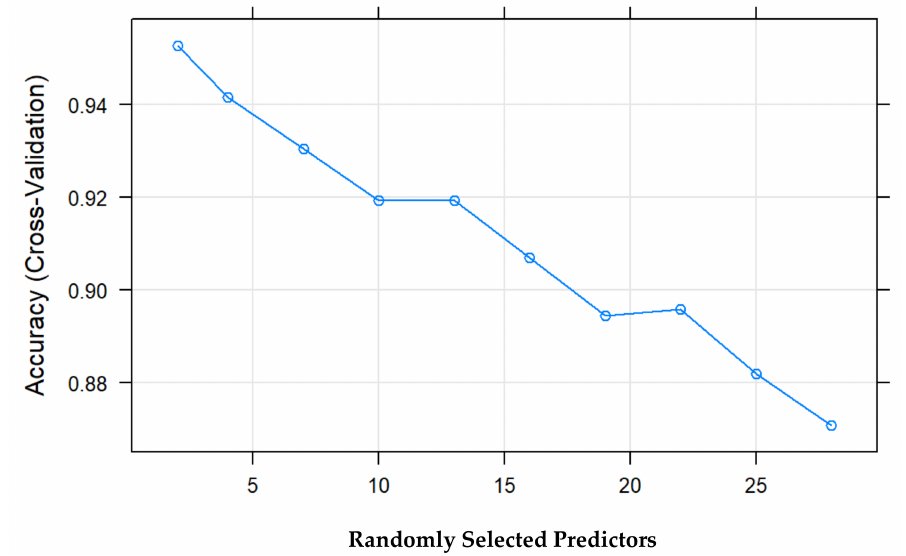
Figure 2. Percentage of success vs. predictors of the model.